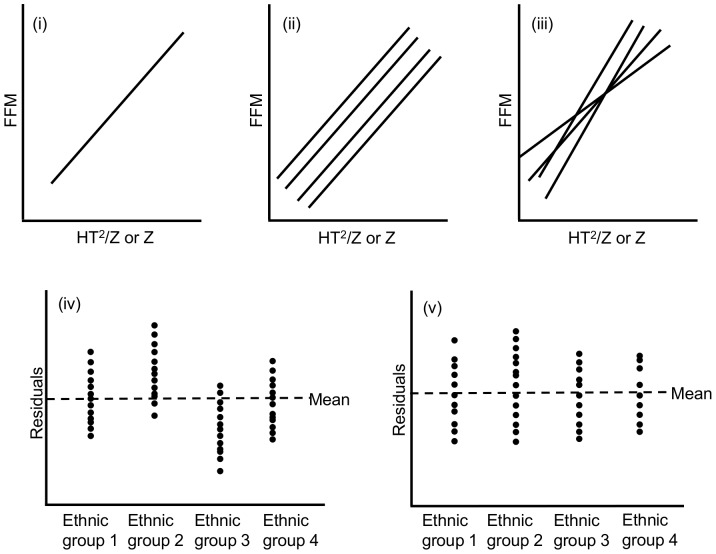
Conceptual illustration for deriving the ‘best’ BIA equation.Calibration equations aim to describe the relationship between fat-free mass (FFM) and height2/impedance (HT2/Z) or impedance (Z). Three types of calibration equations were investigated: (i) a generic equation with no ethnic terms; (ii) a simple ethnic-specific equation (same slope, different intercept); (iii) a complex ethnic-specific equation with ethnic-impedance interaction terms (different slopes, different intercepts). Model can have very similar average residuals but the distribution of residuals may vary across ethnic groups (iv). To avoid ethnic bias, models with even residual distribution (v) are preferred.